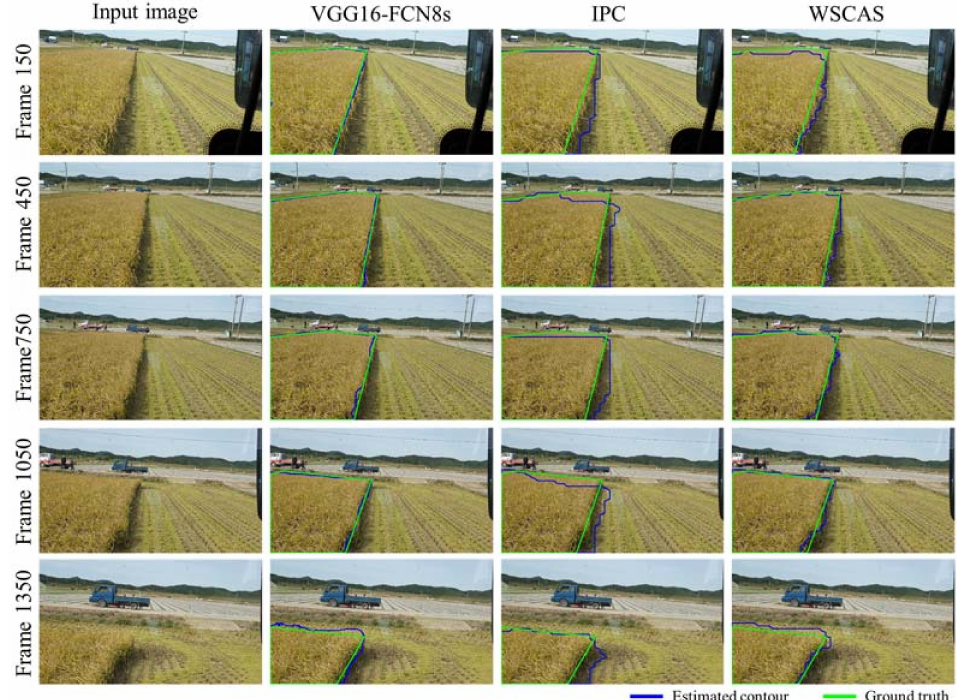
Figure 5. Representative contour lines for several frames that have 300 regular intervals from the top to the bottom row. Each row consists of four images: the input image and the segmentation results using VGG16-FCN8s, IPC, and WSCAS from left to